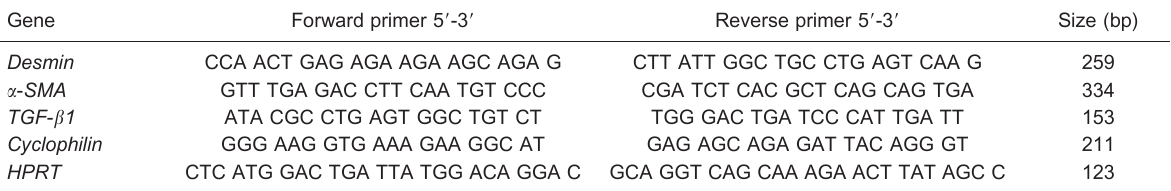
Table 1. Primers used for the semiquantitative polymerase chain reaction (RT-PCR) and the real-time quantitative PCR (qRT-PCR).